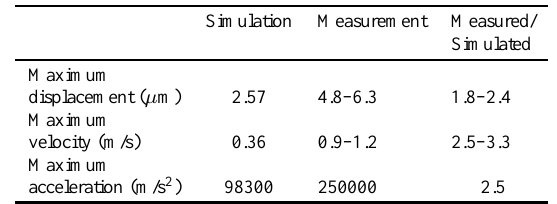
Simulation Measurement Measured/